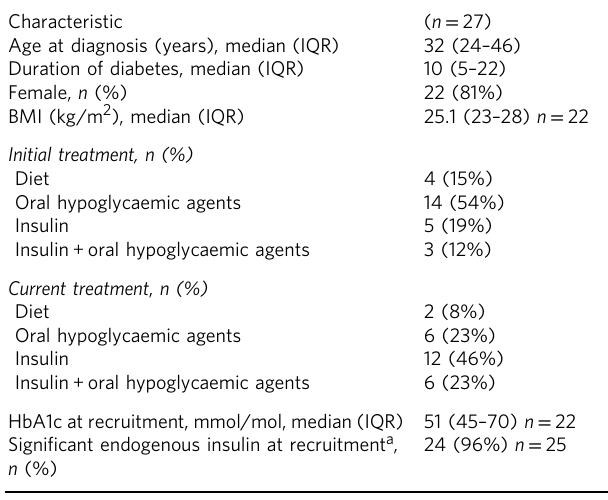
Table 2 Clinical characteristics of patients with RFX6